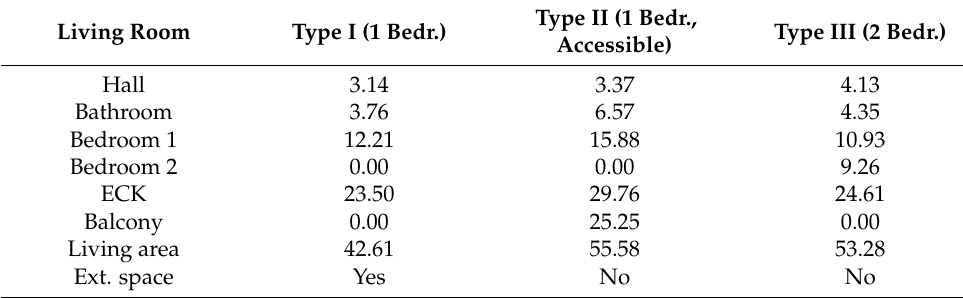
Table 6 summarises the floor areas of the studied typologies. Table 6. Surface areas per room and type, in square metres.